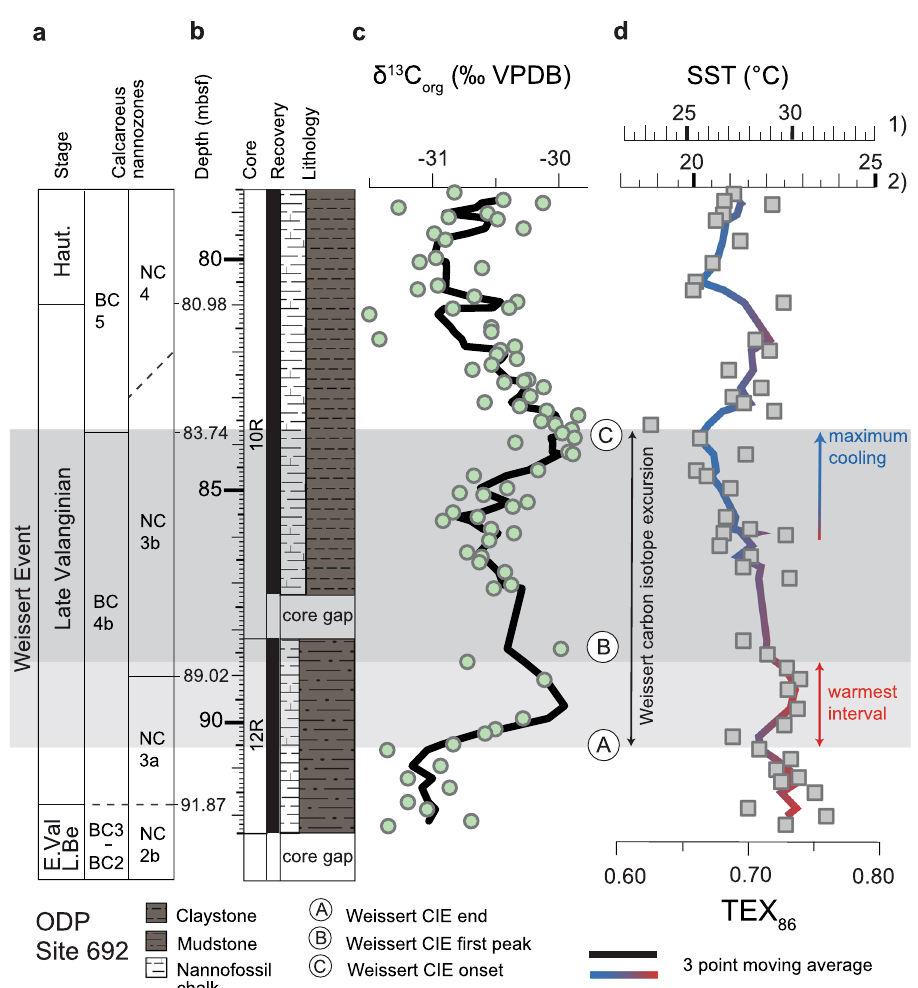
Fig. 2 Carbon isotopes and sea surface temperatures (SSTs) of cores 10R and 12R at ODP Site 692. a Stage and calcareous nannofossil zonation (Boreal Realm, BC 65 zonation and Tethys, NC 66 zonation). b Depth in metres below sea fl oor (mbsf), cores (12R and 10R), core recovery, and lithology. c Stable carbon isotope record measured on bulk organic matter ( δ 13 C org with green circles and a black curve reporting the calculated three point moving average) and identi fi cation of the Weissert positive carbon isotope excursion (CIE) segments (A, Weissert CIE onset; B, Weissert CIE fi rst peak; C, Weissert CIE end). d Organic TEX 86 paleothermometry (grey boxes and a shaded red (warmer values) — blue (colder values) curve reporting the calculated three point moving average) and the calibration to SSTs in degree °C showing (1) BAYSPAR and (2) restricted basin calibrations, representing maximum and minimum temperature estimates based on TEX 86 ,